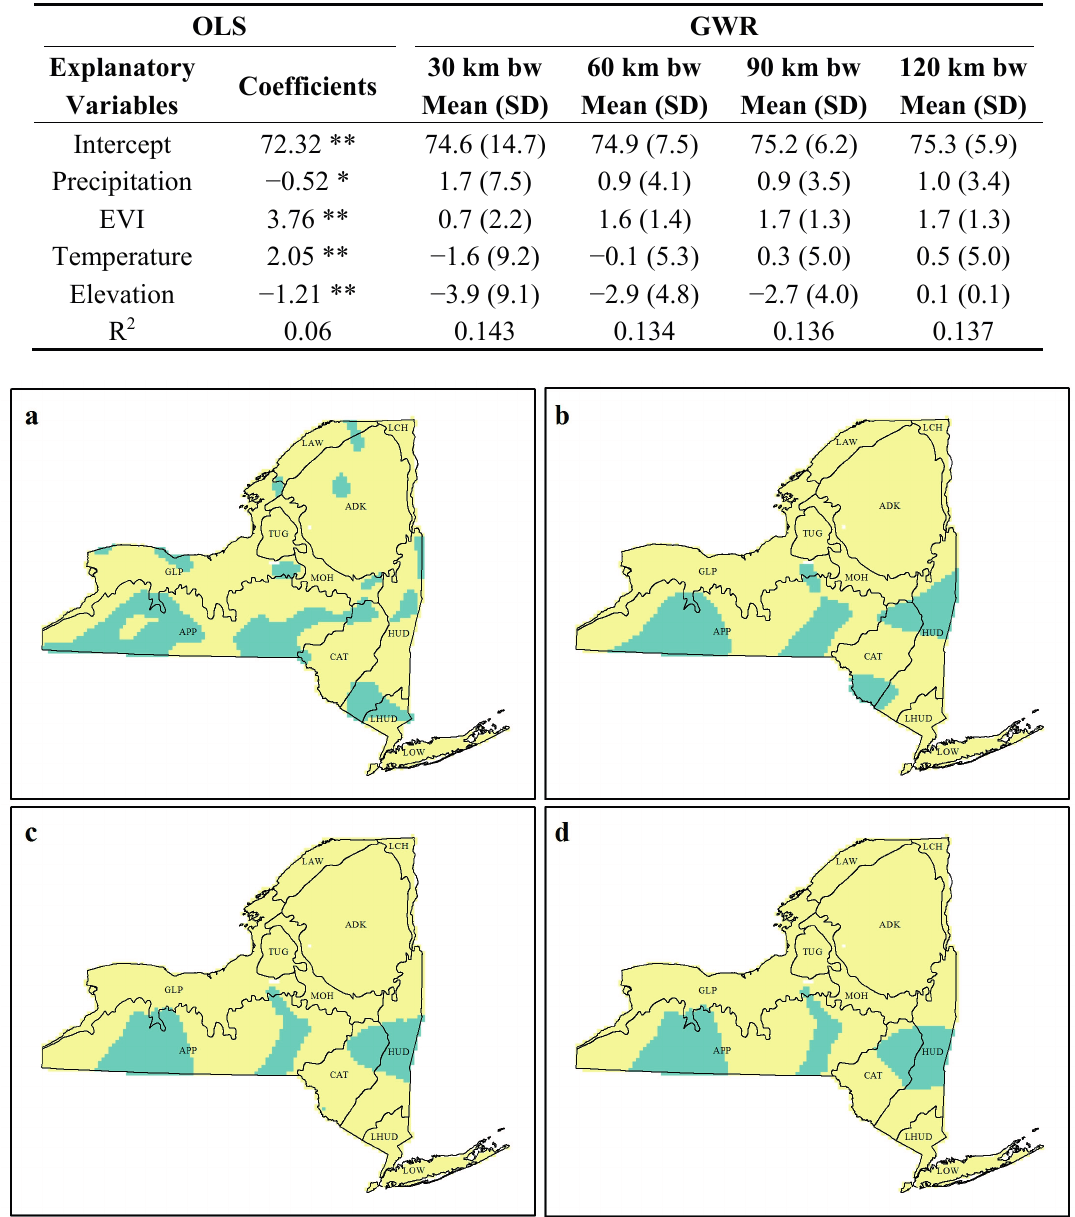
Table 2. Regression results from ordinary least squares (OLS) and geographically weighted regression (GWR) (tested at four bandwidths). * significant at 0.05, ** significant at 0.01.